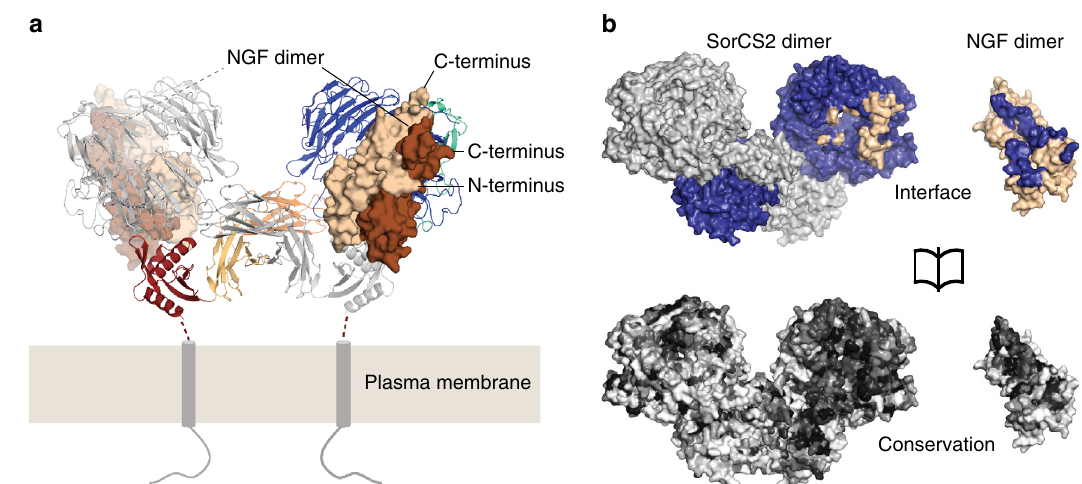
Fig. 2 NGF binds to the top face of the sSorCS2 β -propeller to form a 4:2 complex. a The sSorCS2 – NGF complex with the cell surface indicated. An NGF dimer is bound to each sSorCS2 chain. SSorCS2 is depicted in cartoon representation (colored according to Fig. 1b) and NGF in surface representation with the two dimer chains colored differently. b Opened view of the SorCS2 – NGF interface (top, with one sSorCS2 monomer colored blue and the other gray) and the Consurf gradient conservation plot (based on SorCS members 1 to 3 and on proneurotrophins) on the surface of the sSorCS2 – NGF complex (bottom), from white (not conserved) to black (highly conserved). The conservation of the interaction sites in both SorCS2 and NGF suggest the sSorCS2 – NGF structure represents a common binding mode for other SorCS members and